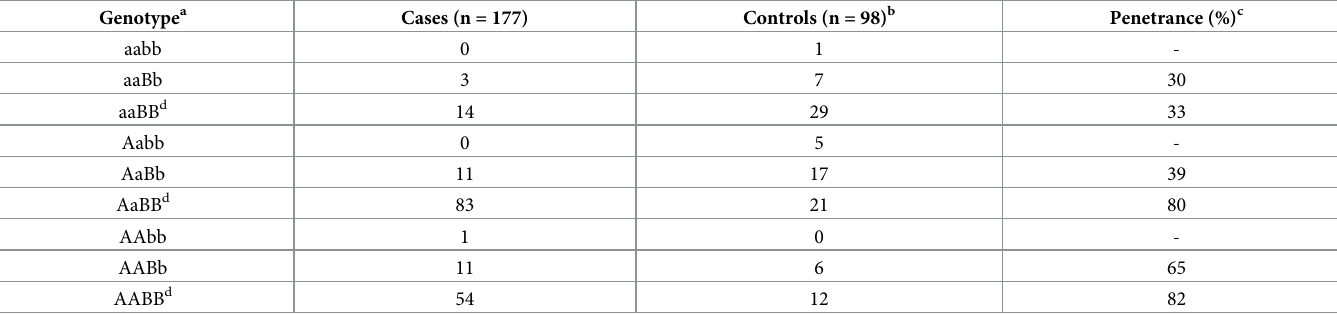
a “A” represents the risk haplotype at CFA5; “a” is any non-risk haplotype. “B” represents the risk allele at the CFA19 lead SNP; “b” is non-risk. b Controls were � 11 years of age at sample collection. c The proportion of dogs with each genotype who are cases.